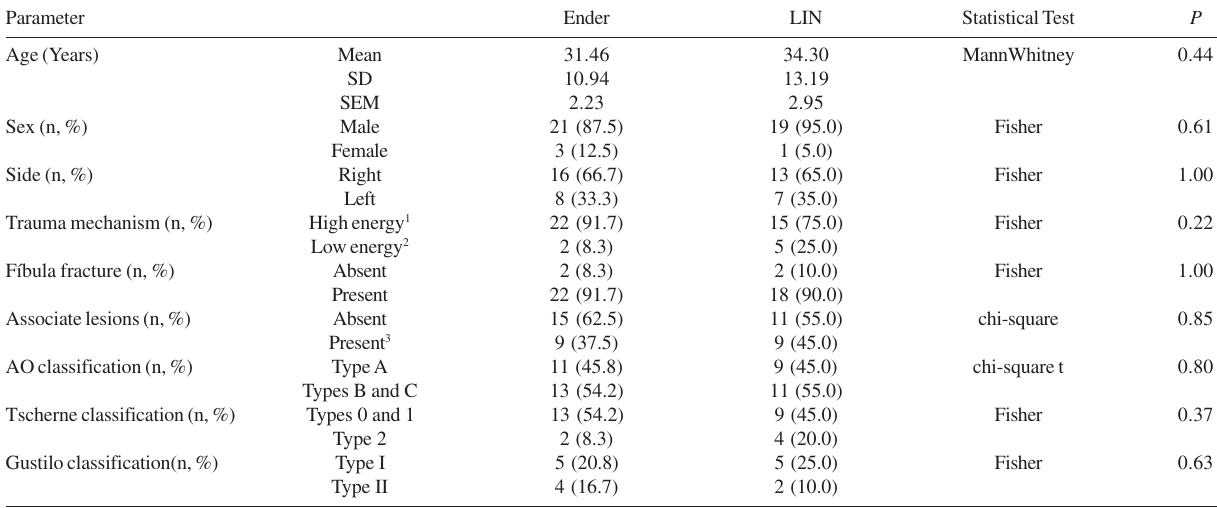
Table 1 - Descriptions of both groups according to age, sex, fracture, side, trauma mechanism, and classifications Parameter